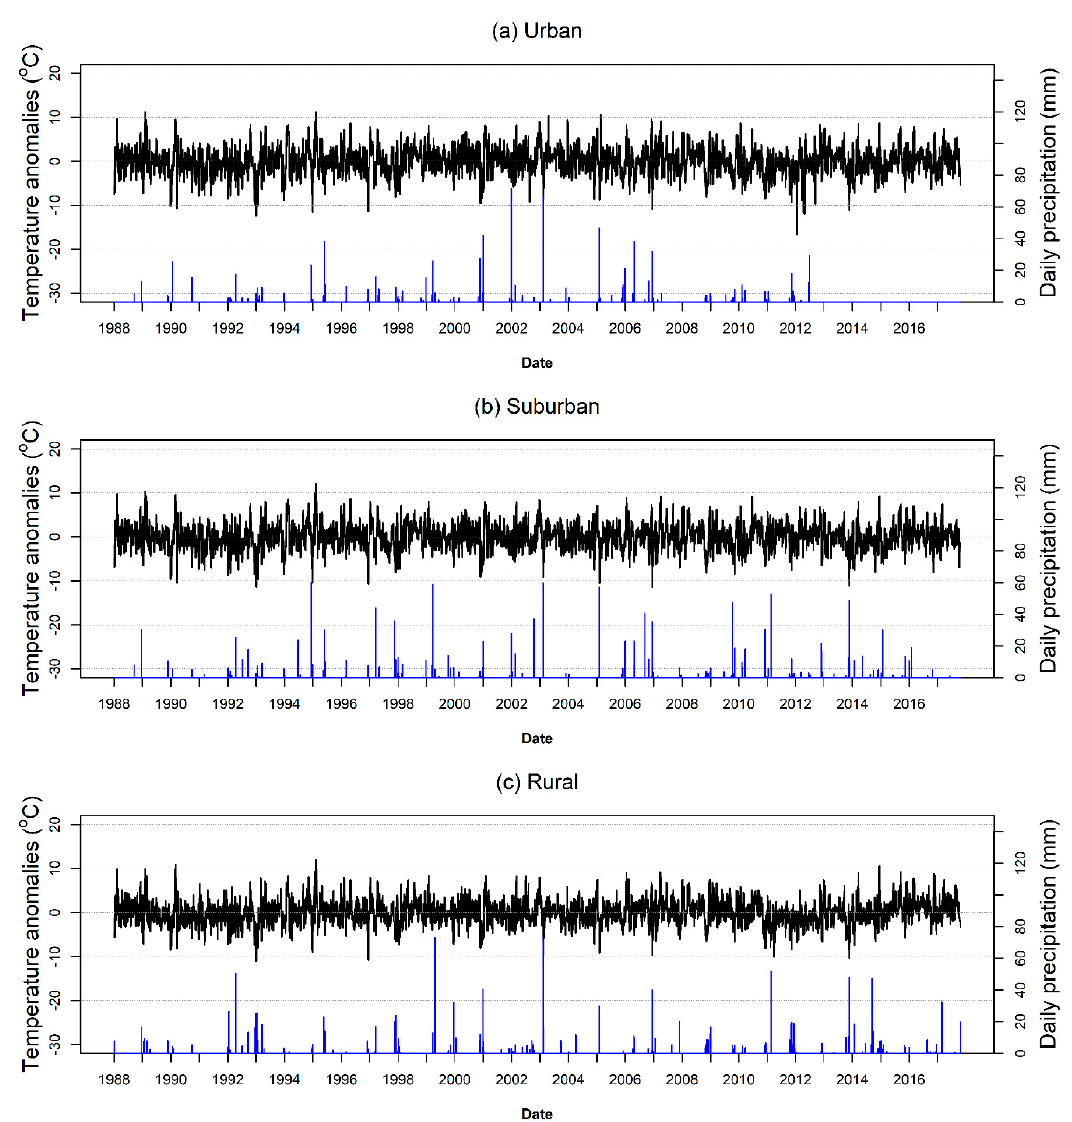
Figure 6. Time series of precipitation levels (blue bars) and temperature anomalies (black line) for months May to September for years 1988–2017. Table 4. Monthly mean and standard deviation (sd) values of SPEI and temperature anomalies (T anomaly) for urban, suburban, and rural station.